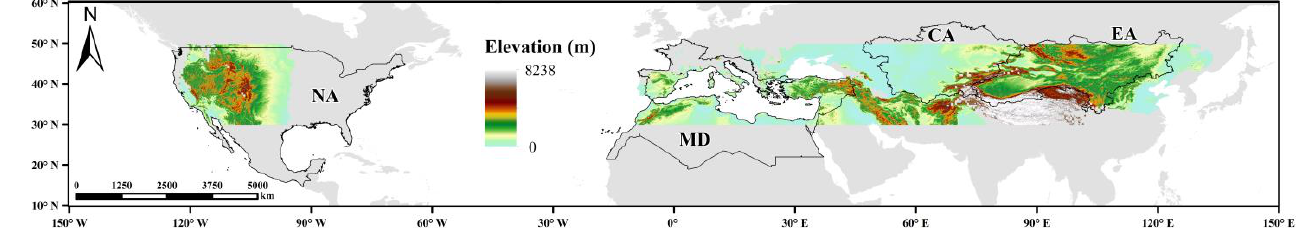
Figure 2. Elevation in the drylands between 30 and 50°N.